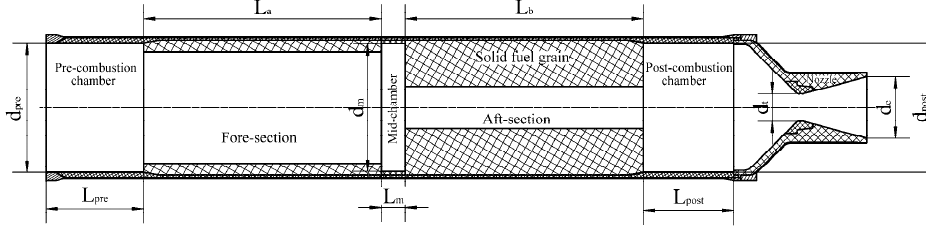
Figure 1. Full-scale motor with star-segmented rotation grain.